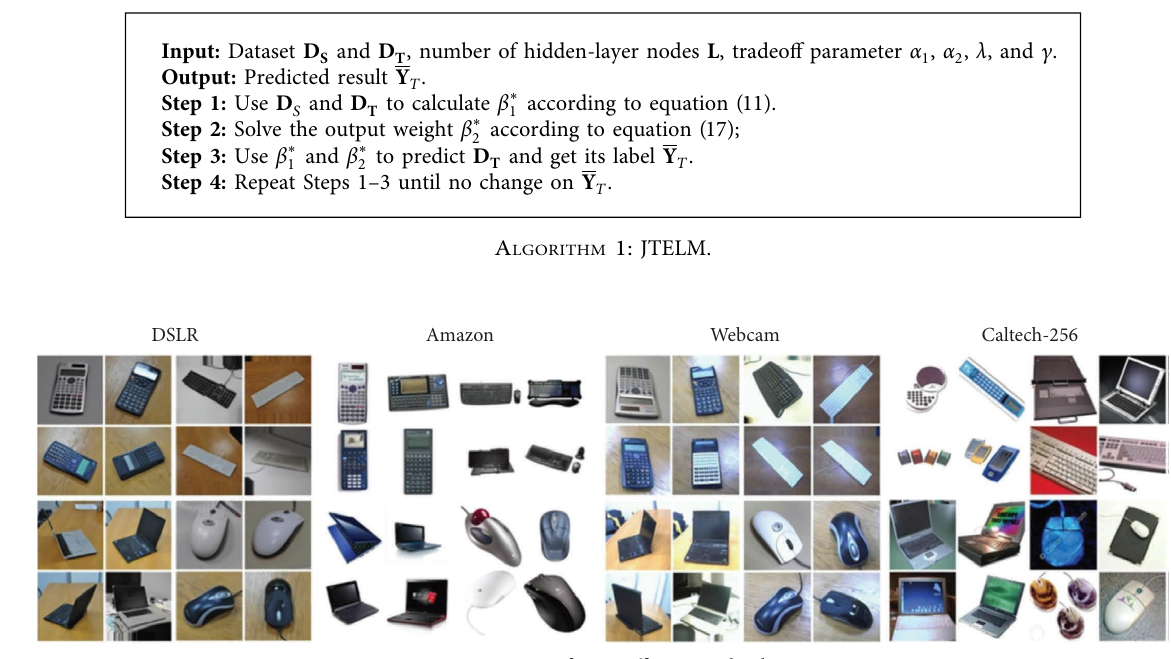
Figure 2: Images from Ofce31+Caltech256. Table 1: Description of image and text datasets.